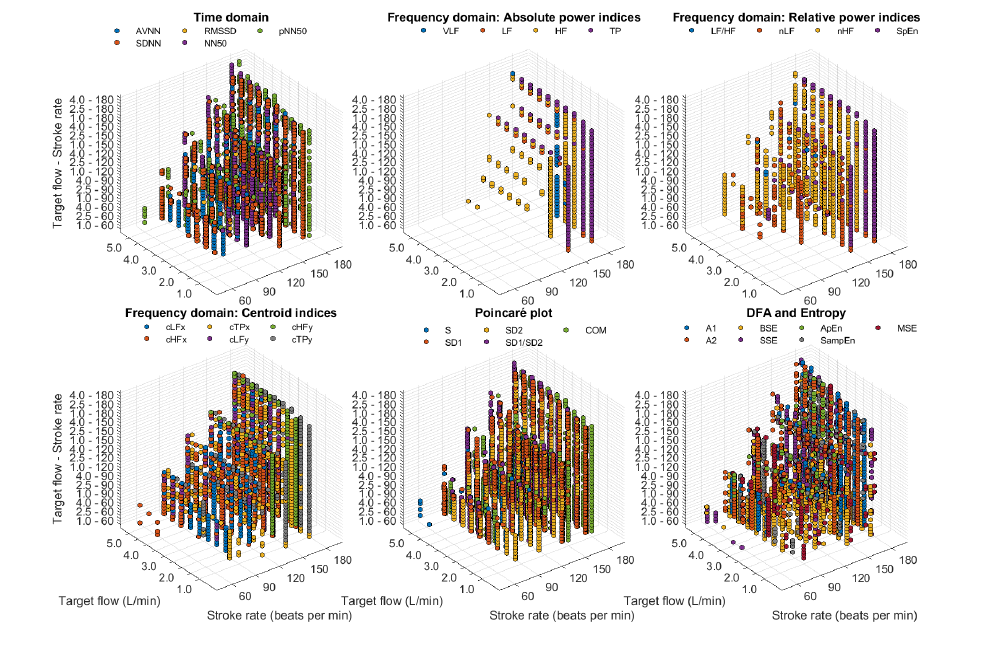
Figure 14. Post-hoc comparisons for the interaction between stroke rate (SR) and target flow (TF) when pulse rate variability indices are measured from the deep palmar arch phantom. The appearance of a circle indicates a significant difference between the corresponding levels for each of the